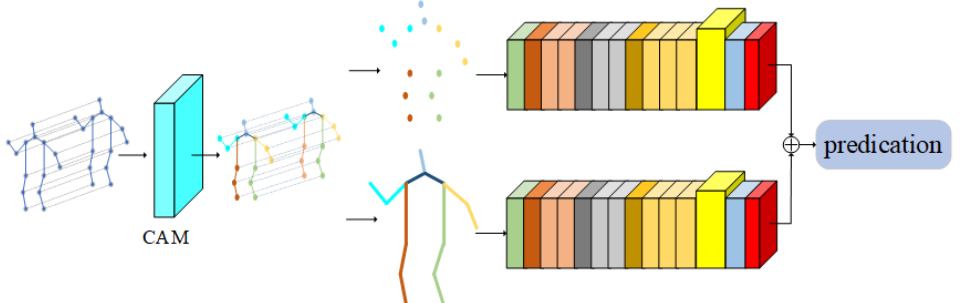
Figure 3. Multiple attention mechanism convolution action-recognition model based on action coordination theory